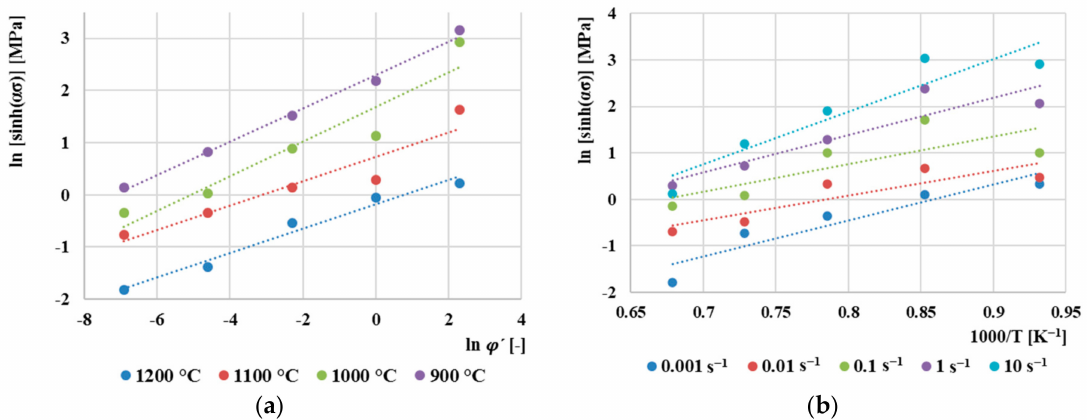
(cid:16) . (cid:17) ϕ for derivation of n parameter, ( b ) dependence